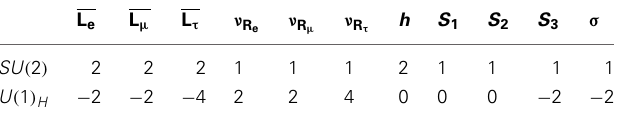
Table 2 | Model field representation content and